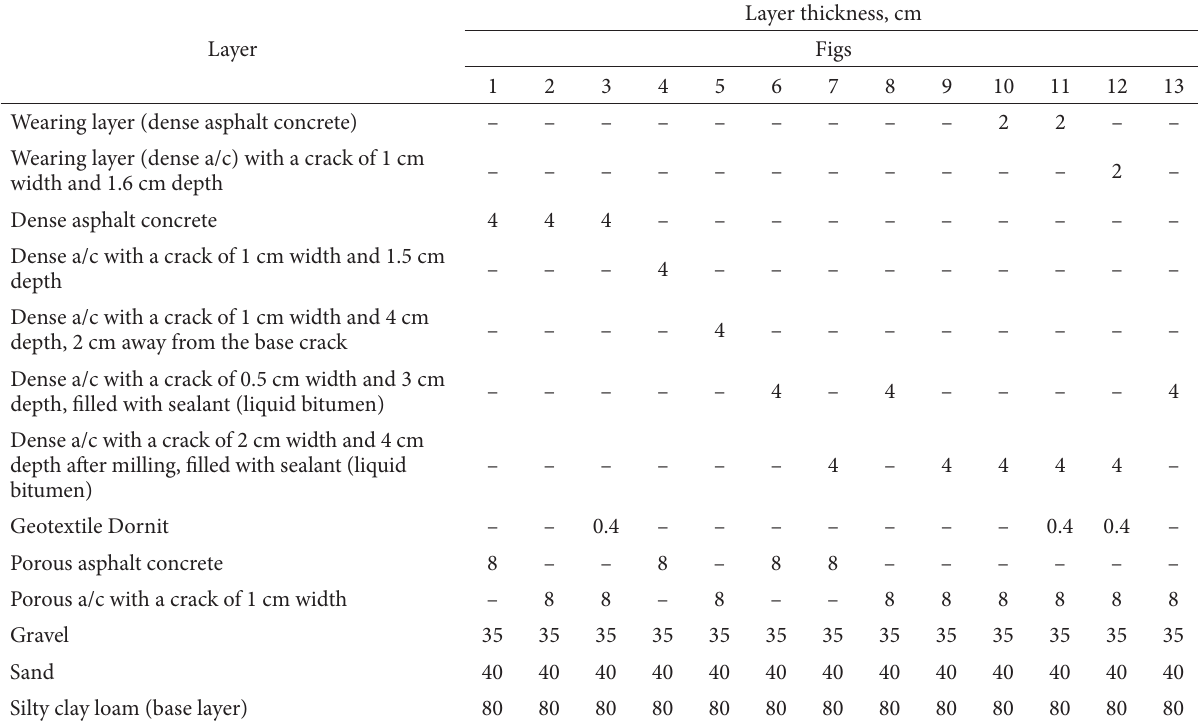
Table 1. Road structure of modeled schemes (schemes in Figs 1–13)